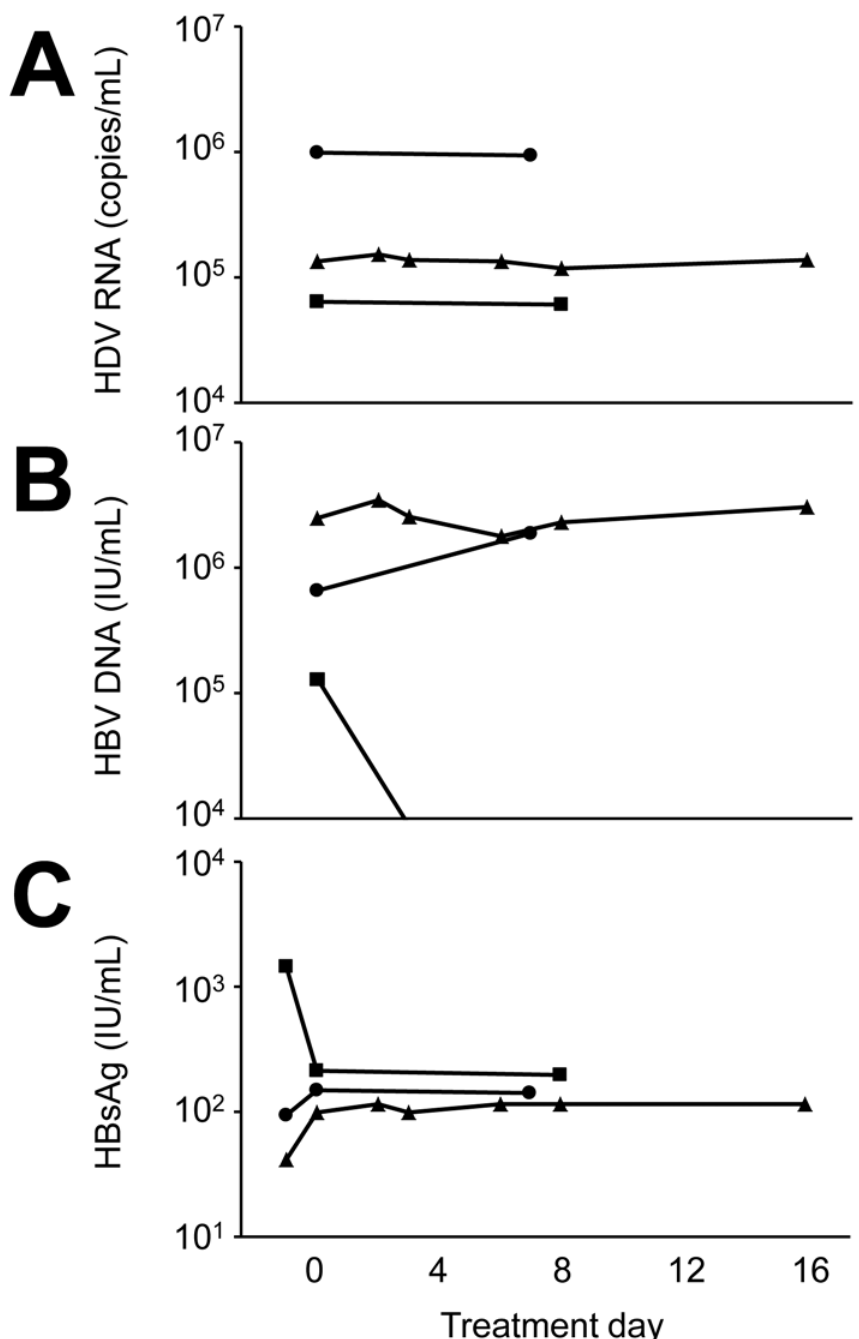
Fig 6. Effect of short-term administration of chenodeoxycholic acid on serum HDV RNA. Three individuals with chronic HBV/HDV coinfection (circle, triangle and square) were administered chenodeoxycholic acid 15 mg/kg daily orally in three doses. (A) Serum HDV RNA, (B) serum HBV DNA and (C) HBsAg were determined before the first dose and at the indicated time points thereafter. The last symbol in each line indicates serum levels after the final dose of chenodeoxycholic acid. HBV DNA for one patient (square) was not detectable on day 8.